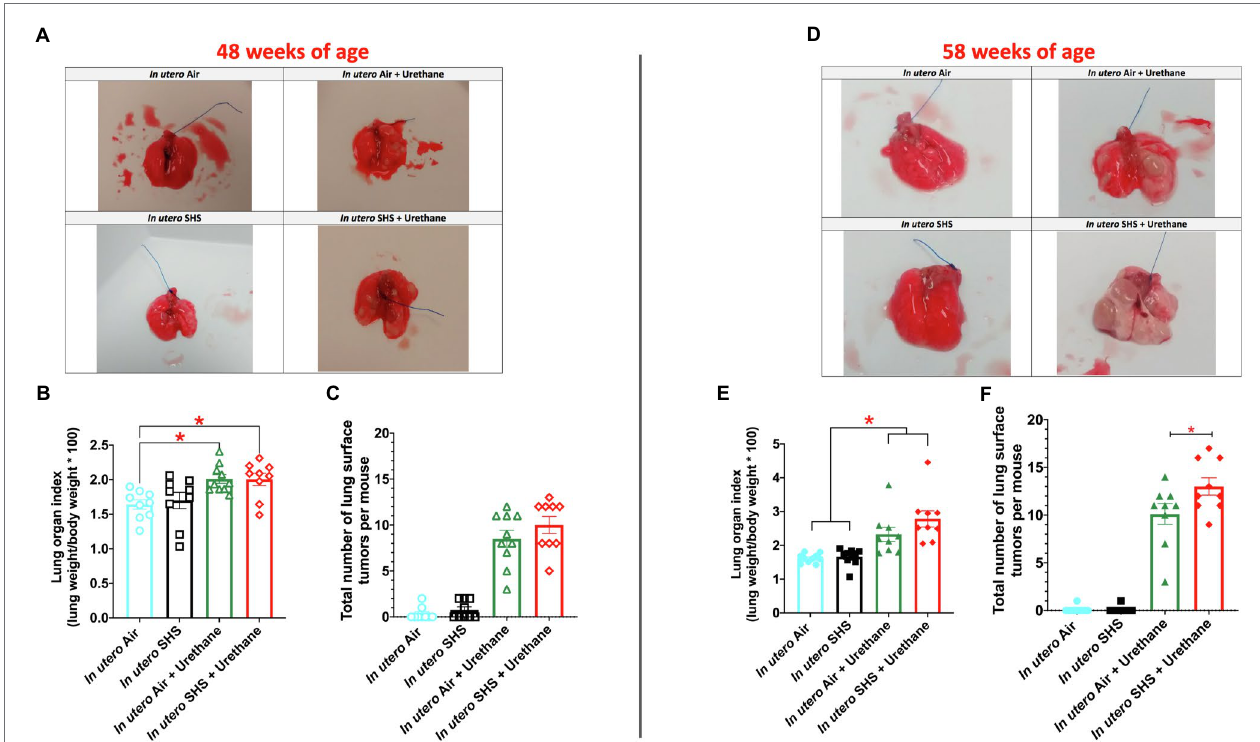
FIGURE 8 | In utero SHS plus adult urethane increased the lung organ index and the total number of lung surface tumors at 58 weeks of age. (A,D) Representative images of excised lungs from 48- and 58-week-old female mouse offspring, respectively, with urethane, treated groups showing lung surface tumors. (B,E) Lung organ index calculated as: (lung weight/body weight) × 100. N = 9–10 per group, data are expressed as mean ± SEM. ANOVA followed by the Tukey’s test for multiple comparisons, * p < 0.05: statistically different from in utero air plus saline group. (C,F) . The total number of visible lung surface tumors measured using an electronic digital caliper in 48- and 58-week-old mice, respectively. N = 9–10 per group, data are expressed as mean ± SEM. ANOVA followed by the Tukey’s test for multiple comparisons, * p < 0.05: statistically different from in utero air plus urethane